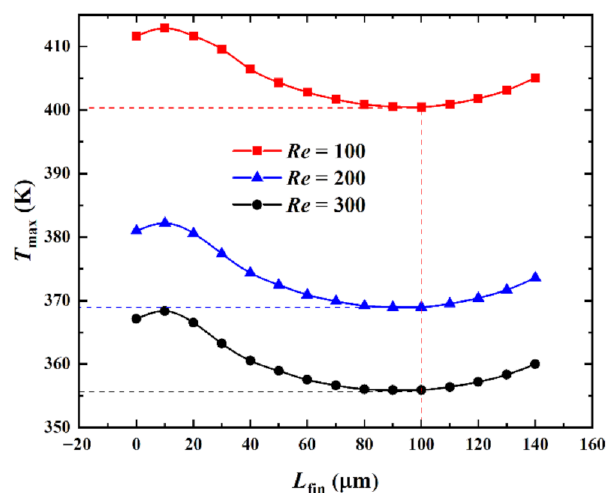
Figure 8. Effect of Re on T max versus L fin